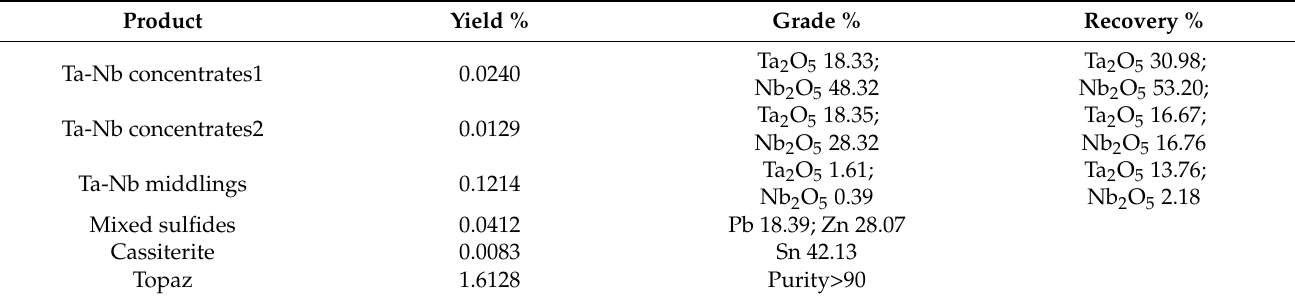
Figure 9. Flow-sheet for separation of tantalum-niobium minerals. Figure 9. Flow ‐ sheet for separation of tantalum ‐ niobium minerals. Table 5. Results of the separation of tantalum-niobium